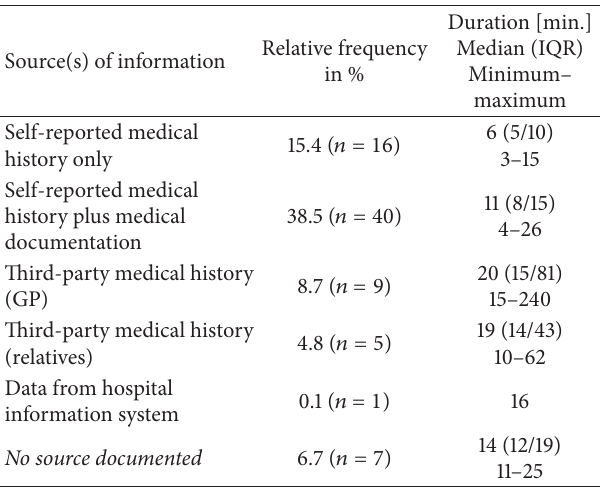
Table 1: Sources of information and time until successfully com- pleted basic medical history ( 𝑛 = 78